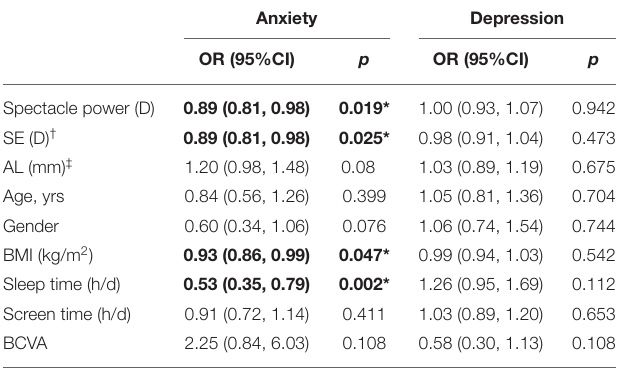
TABLE 2 | Associations of demographic, lifestyle and vision characteristics with anxiety, and depression status ( n = 764).